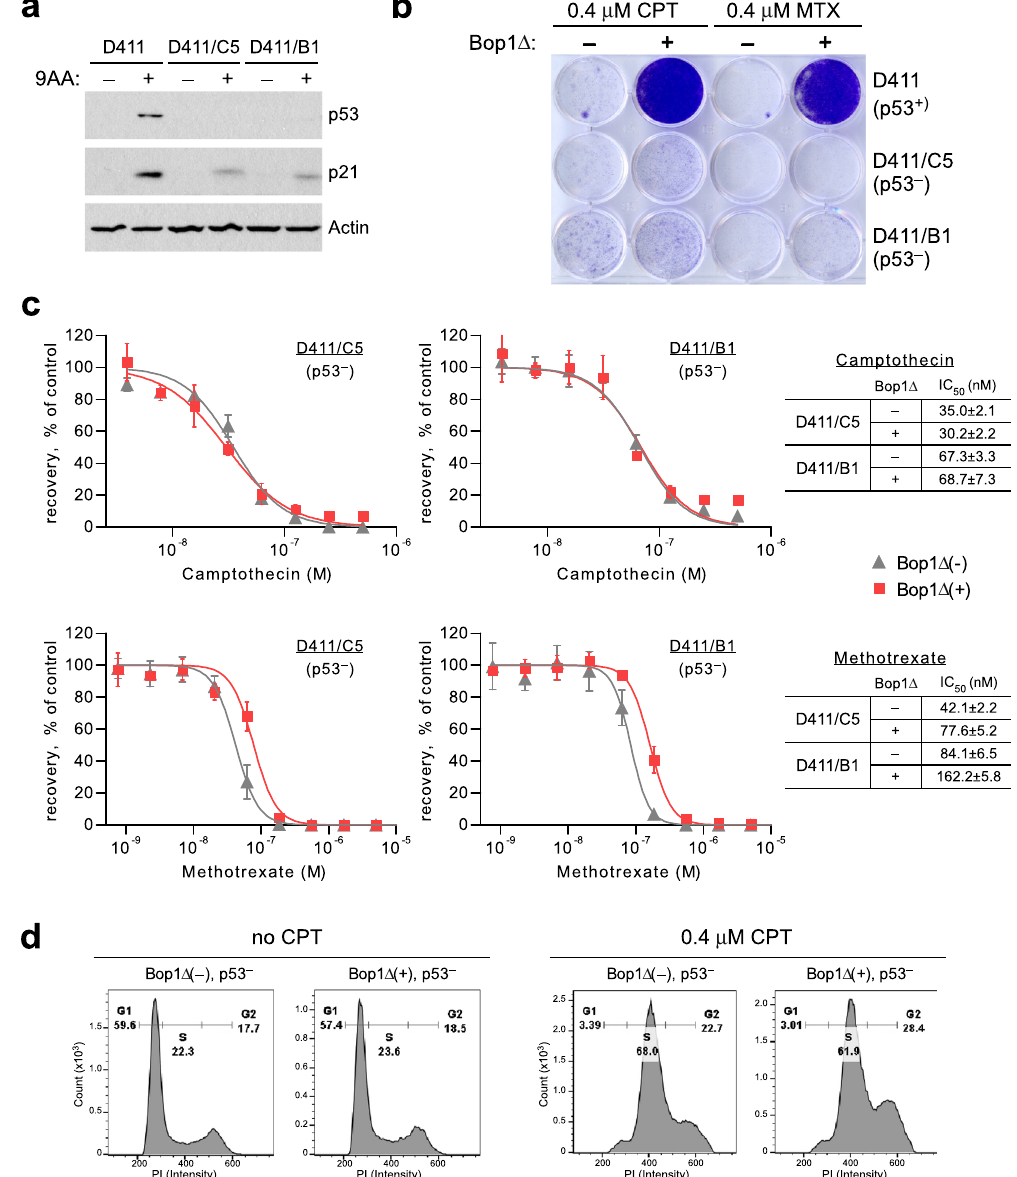
Figure 3. p53 is necessary for nucleolar stress-induced cytoprotection. ( a ) Verification of the p53-deficient status of Bop1 Δ -inducible cell lines D411/C5 and D411/B1. To upregulate p53 protein levels, cells were treated for 6 h with 10 μ M 9-aminoacridine (9AA), a strong activator of p53 77 . Representative immunoblots of p53 and p21 levels are shown in comparison with the parental D411 cell line; β -actin was used as a loading control. Full- size immunoblot images are shown in Supplementary Figure S7. ( b ) p53-deficient cells are sensitive to CPT and MTX regardless of the induction of Bop1 Δ . D411 and its p53-null derivatives were stained with crystal violet after treatment with CPT for 24 h or MTX for 48 h as detailed in Fig. 1c. ( c ) Bop1 Δ induction has little to no effect on the dose response to CPT and MTX in the p53-deficient cell lines. The assay was performed as in Fig. 2. ( d ) Representative DNA profiles of the D411/C5 cells show that S-phase accumulation caused by 0.4 μ M CPT is not affected by Bop1 Δ expression on the p53-null background. Cell cycle analysis was performed as in Fig.